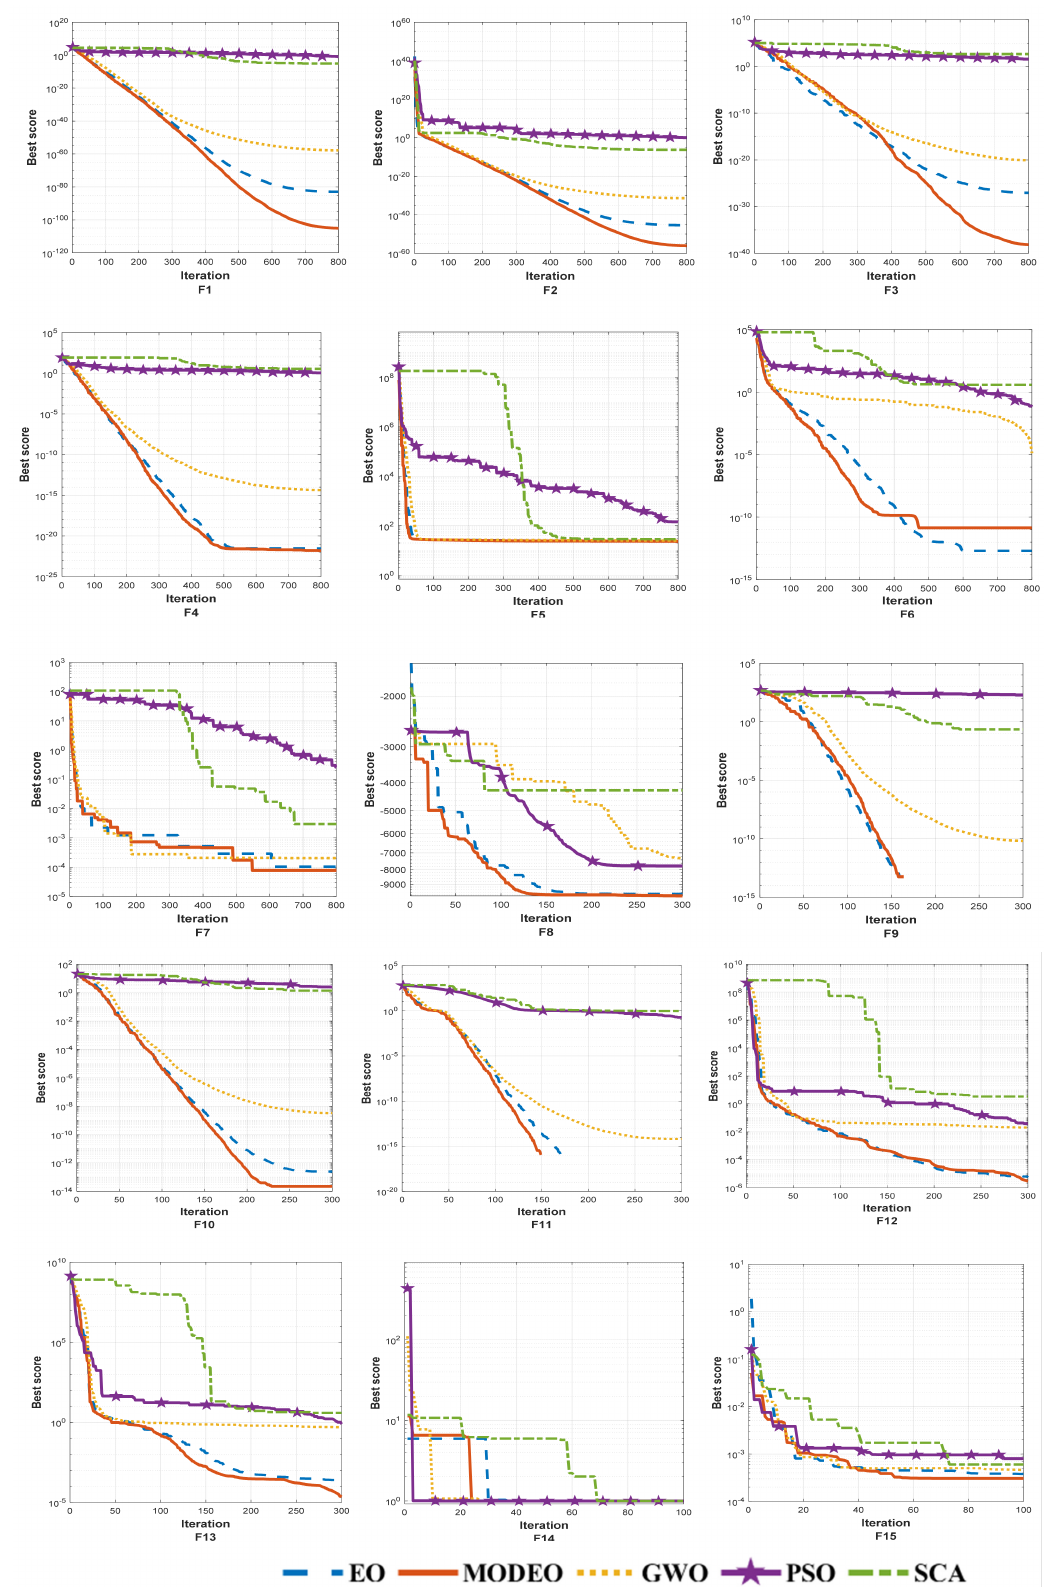
Figure 2. Comparison of convergence curves of the five algorithms for benchmark functions (F 1 -F 15